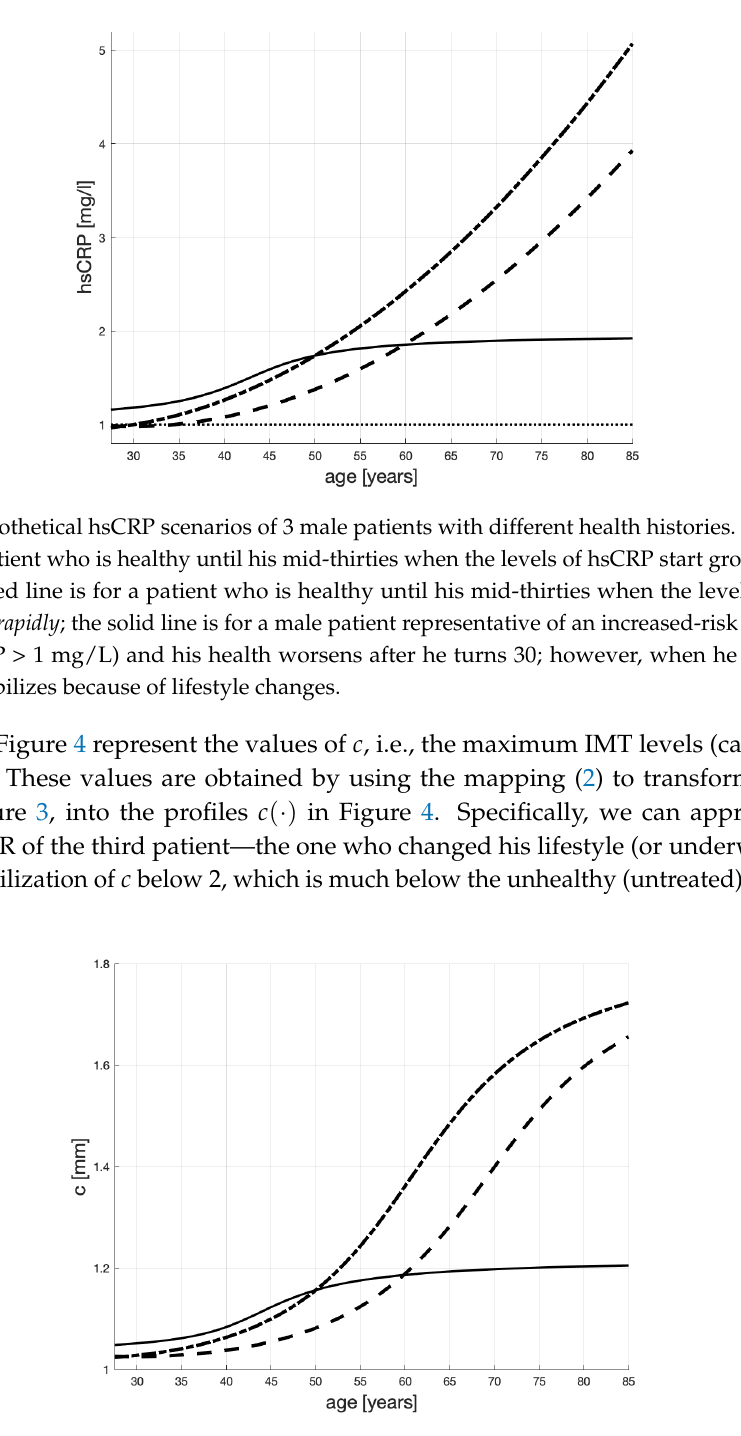
Figure 4. Maximum IMT levels, c , as transformed hsCRP scenarios proposed in Figure 3. The dashed line represents a healthy male until his mid-thirties when the levels of hsCRP start growing slowly; the dash-dotted line—a healthy male until his mid-thirties when the levels of hsCRP start growing rapidly; the solid line—a male representing an increased-risk group (hsCRP > 1 mg/L) since young and his healthiness worsens after he turns 30; however, then, due to the proper conduct, his hsCRP stabilizes when he is about